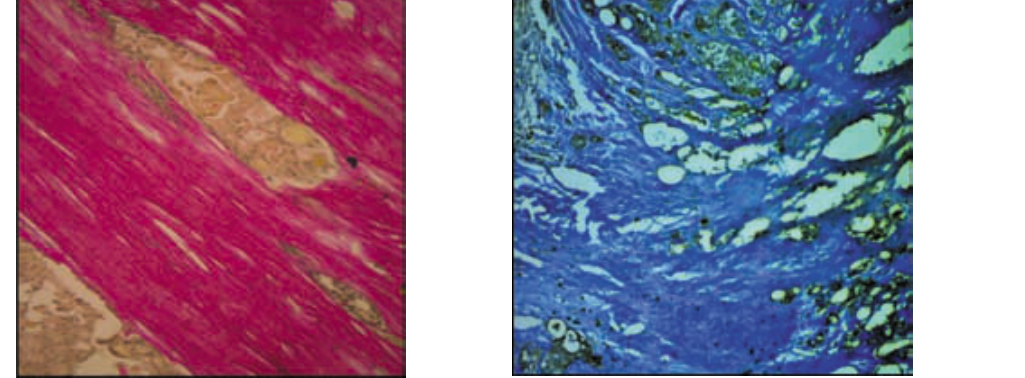
Fig.10. Increased deposition of wavy collagen bundles SEM 4.10kx